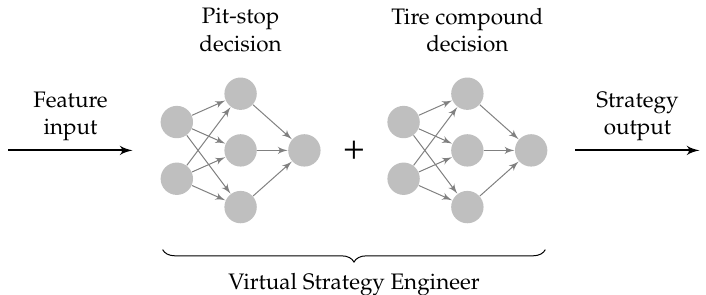
Figure 3. Schematic overview of the virtual strategy engineer (VSE). The neural network for the tire compound decision is called only if the first neural network has decided to make a pit